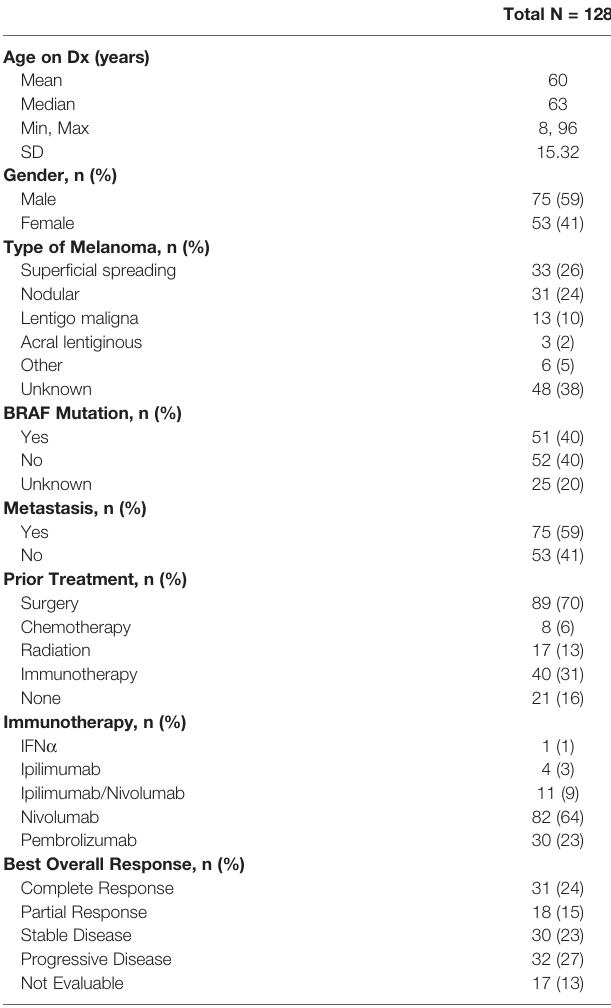
TABLE 1 | Demographic data for the 128 patients included in the study are listed. Disease characteristics, prior treatment modalities including immunotherapy and treatment response are